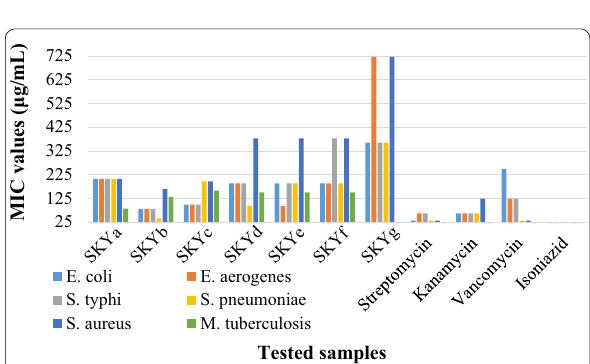
Fig. 5 MIC (μg/mL) of the series of final compounds ( SKYa – SKYg ) against five different bacterial strains viz E. coli , E. aerogenes , S. typhi